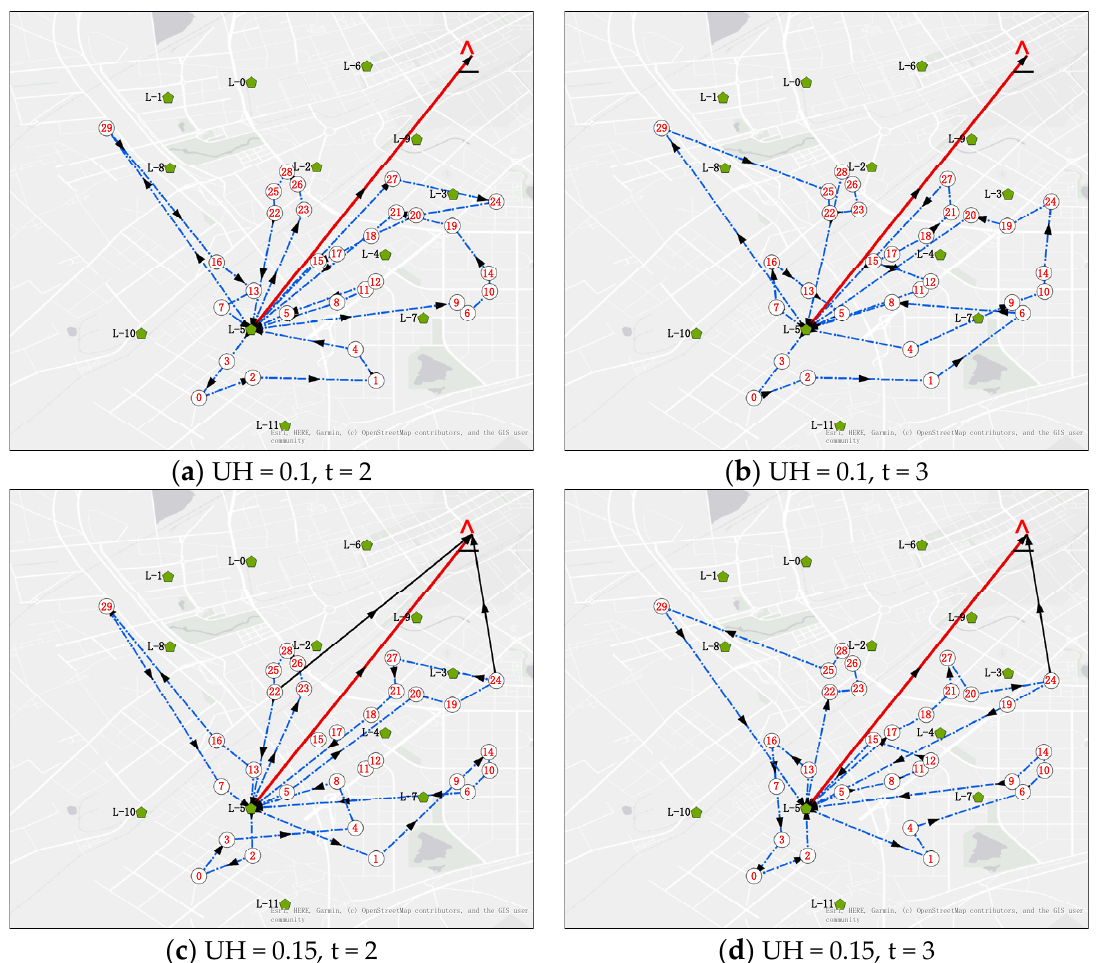
Figure 6. The impact of UH on the routing decisions.